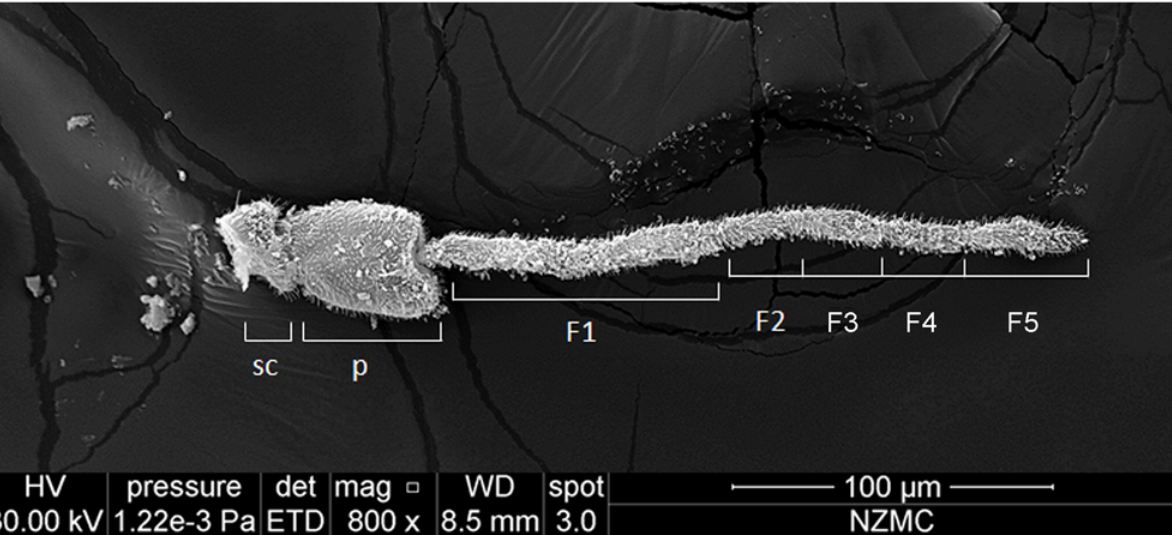
Fig 1. Antenna in female Bemisia tabaci , showing scape (SC), pedicel (P), and flagellum with 5 sub-segments. The antennae from the two B . tabaci cryptic species were the same, only MEAM1 female antenna is shown